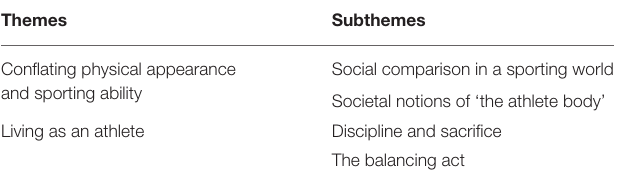
TABLE 2 | Themes and